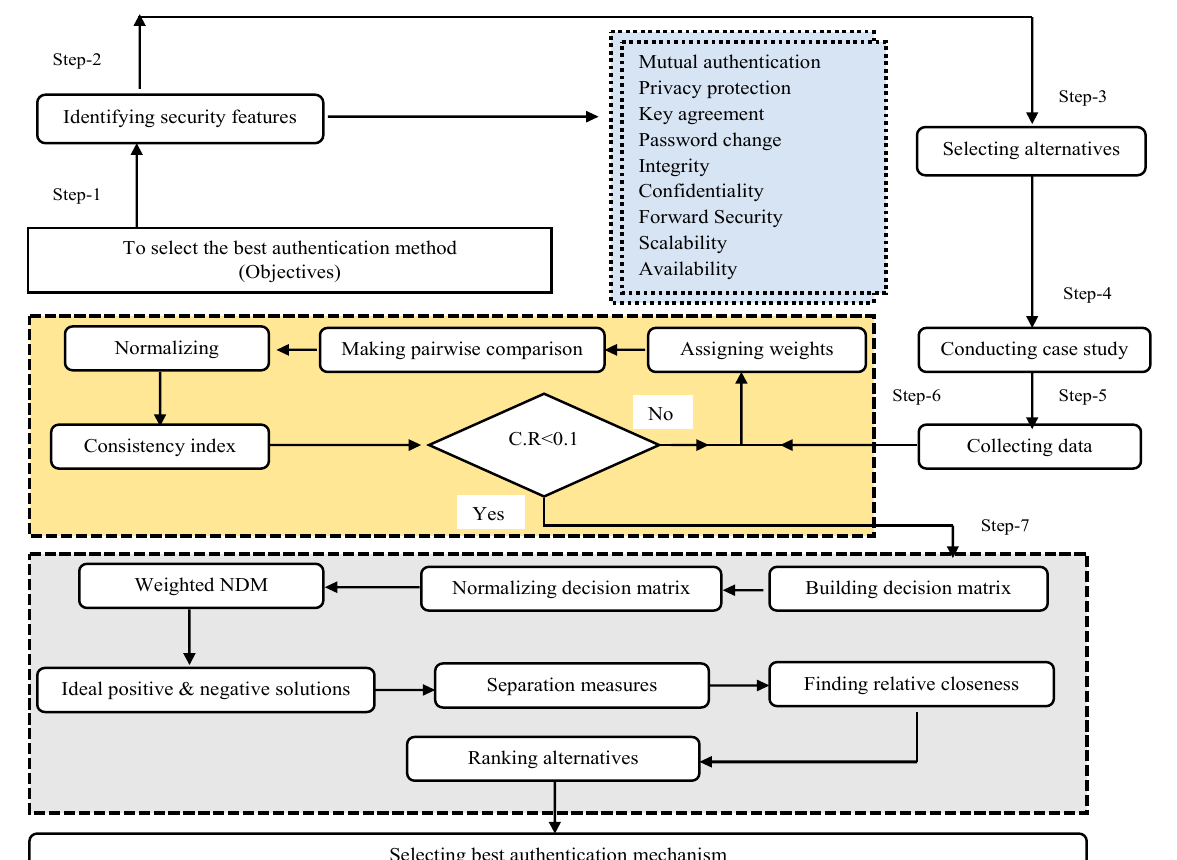
Figure 1. Authentication evaluation framework structure. Table 1. Features